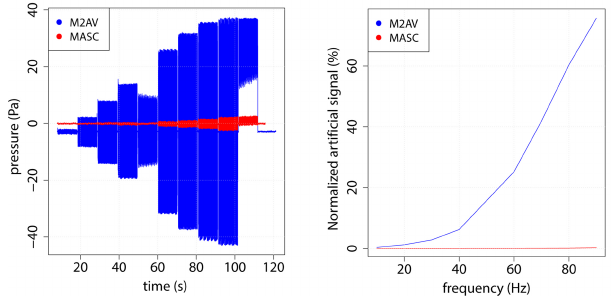
Fig. 14. Acoustic test of the MASC and the M 2 AV tubing system in comparison. Left: raw measurement of the transducers. Right: percentage of prevailing pressure that is measured as an artefact due to different phase shifts at the high and low pressure ports of the